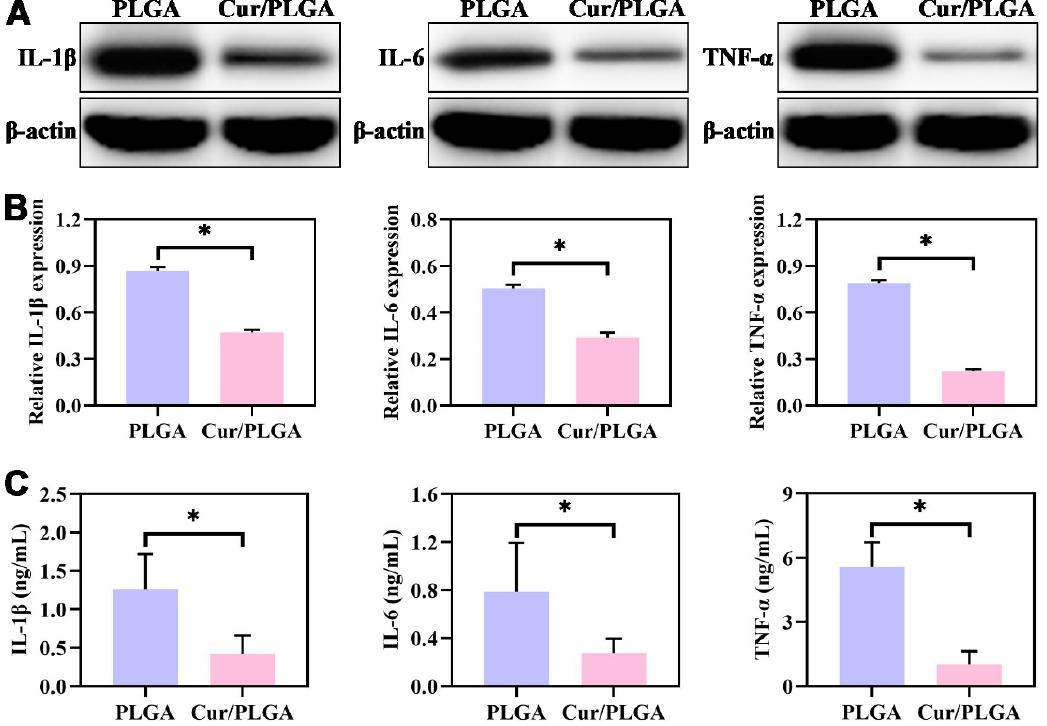
Figure 3. In vitro anti-inflammatory activities of the curcumin/poly(lactic-co-glycolic acid) (Cur/PLGA) nanofibrous membrane: The expression levels of IL-1 β , IL-6, and TNF- α in the PLGA and Cur/PLGA nanofibrous membranes incubated with RAW264.7 macrophages for 24 h were determined using Western blotting ( A ). The quantification of the expression levels of IL-1 β , IL-6, and TNF- α in the PLGA and Cur/PLGA groups from the blots ( B ). The expression levels of IL-1 β , IL-6, and TNF- α in the PLGA and Cur/PLGA nanofibrous membranes incubated with RAW264.7 macrophages for 24 h were also examined using an enzyme-linked immunosorbent assay ( C ). * p < 0.05.